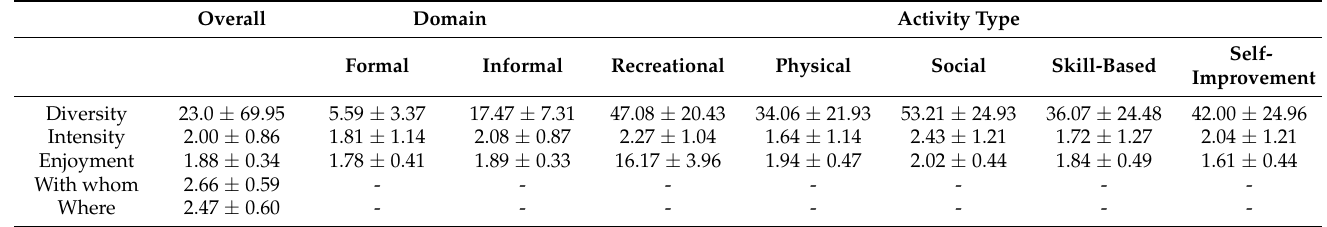
Table 1. Descriptive statistics for the CAPE Scores.